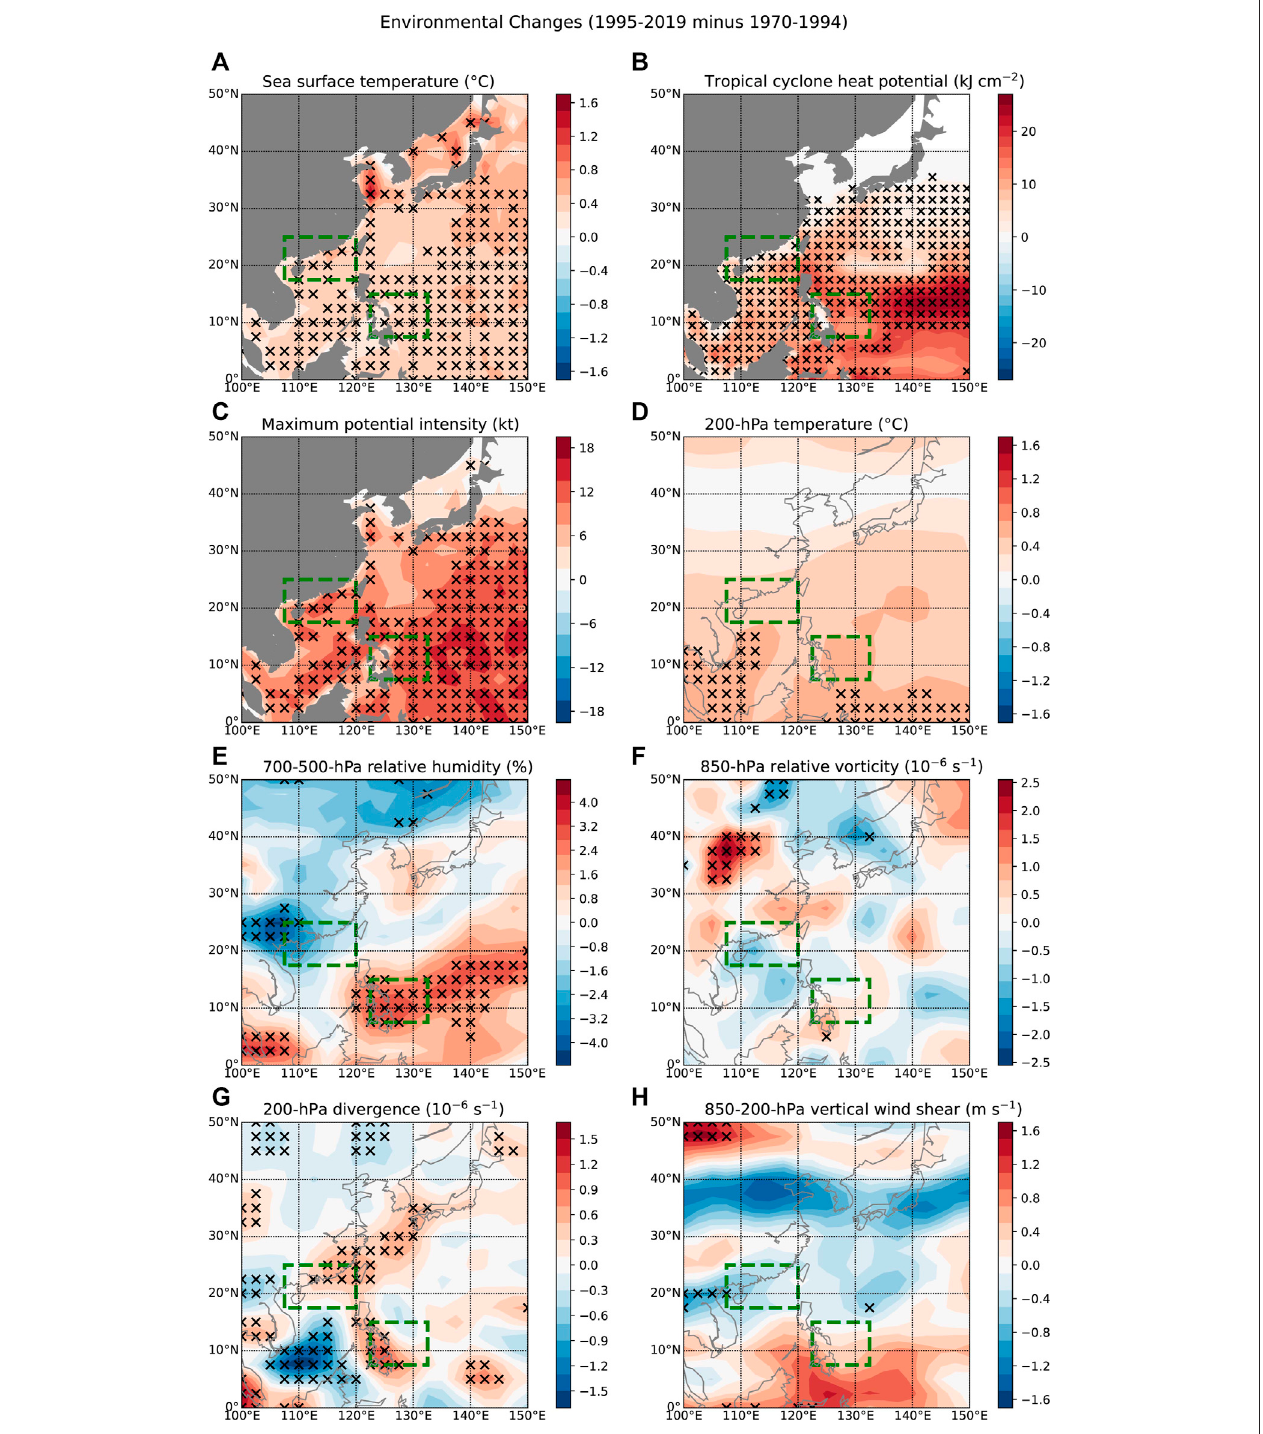
FIGURE 4 | Changes from 1970 – 1994 to 1995 – 2019 for JJASON averages of the following environmental variables: (A) SST, (B) TCHP, (C) MPI, (D) 200-hPa temperature, (E) 700 – 500-hPa relative humidity, (F) 850-hPa relative vorticity, (G) 200-hPa divergence, and (H) 850 – 200-hPa VWS. Black crosses denote values signi fi cant at the 0.05 level based on a Student ’ s t -test. Green boxes denote the two focus regions of this study.